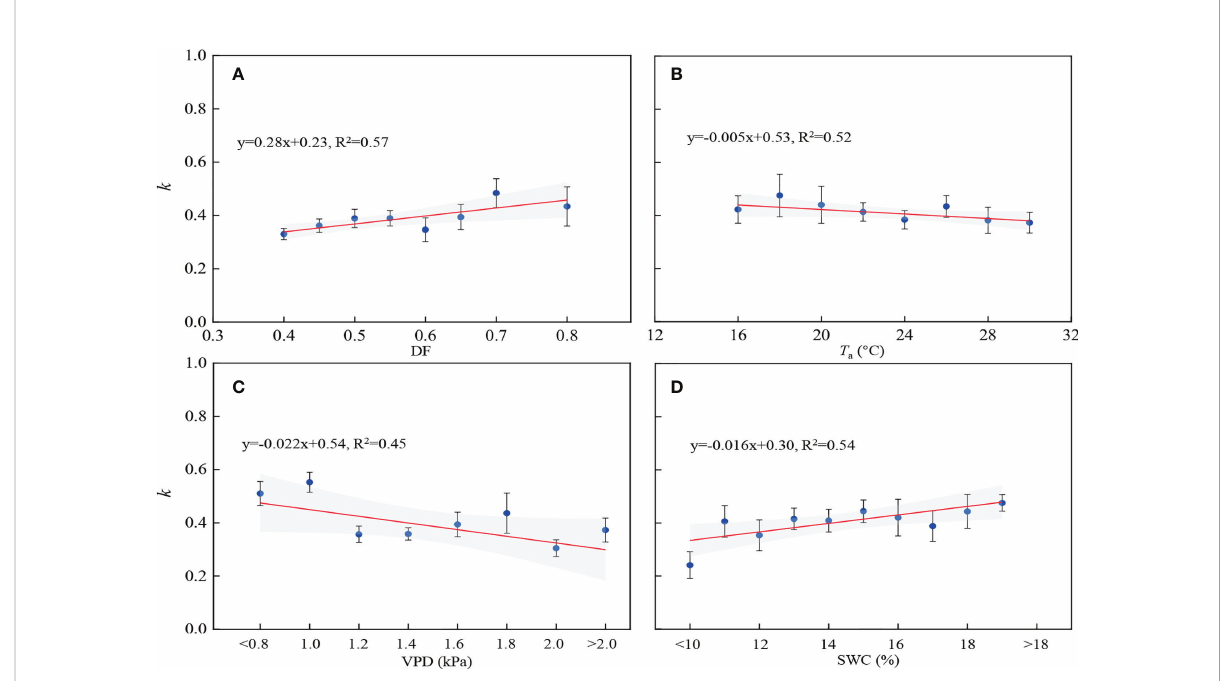
FIGURE 8 Relation between the parameter k of the MM dif model and (A) diffuse fraction (DF), (B) air temperature ( T a ), (C) vapor pressure de fi cit (VPD) and (D) soil water content (SWC).